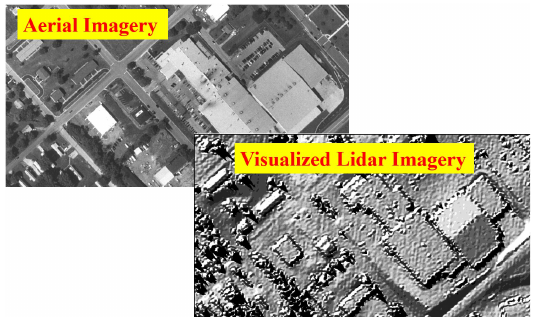
Figure 5: Texture information comparison between aerial imagery vs. LiDAR data set (Courtesy of Zhou et al. (2004))